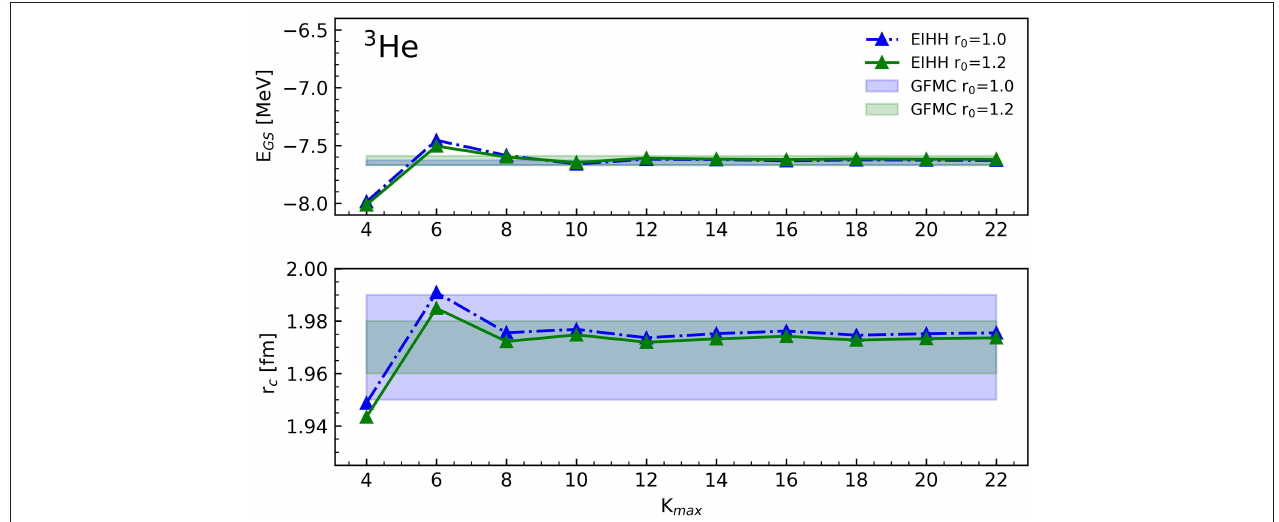
FIGURE 2 | The ground-state energy and the charge radius of the nuclear 3 He system as a function of the grand-angular momentum quantum number K max . The green and blue error-bands are the GFMC results with the relative statistical uncertainty.